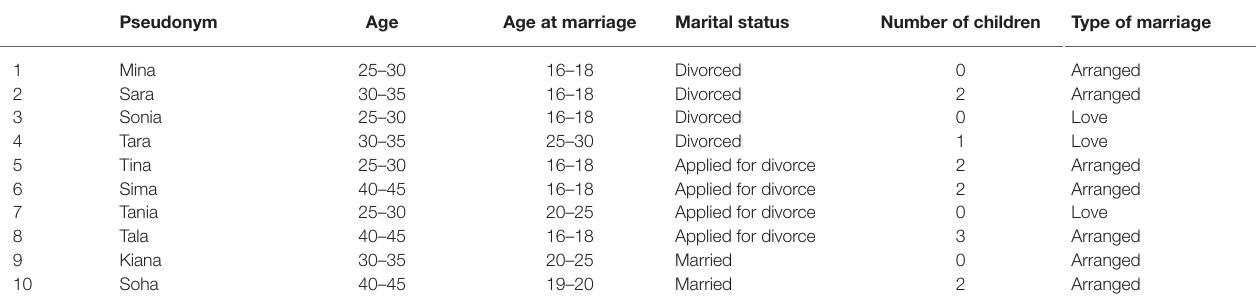
TABLE 1 | Participant’s demographic